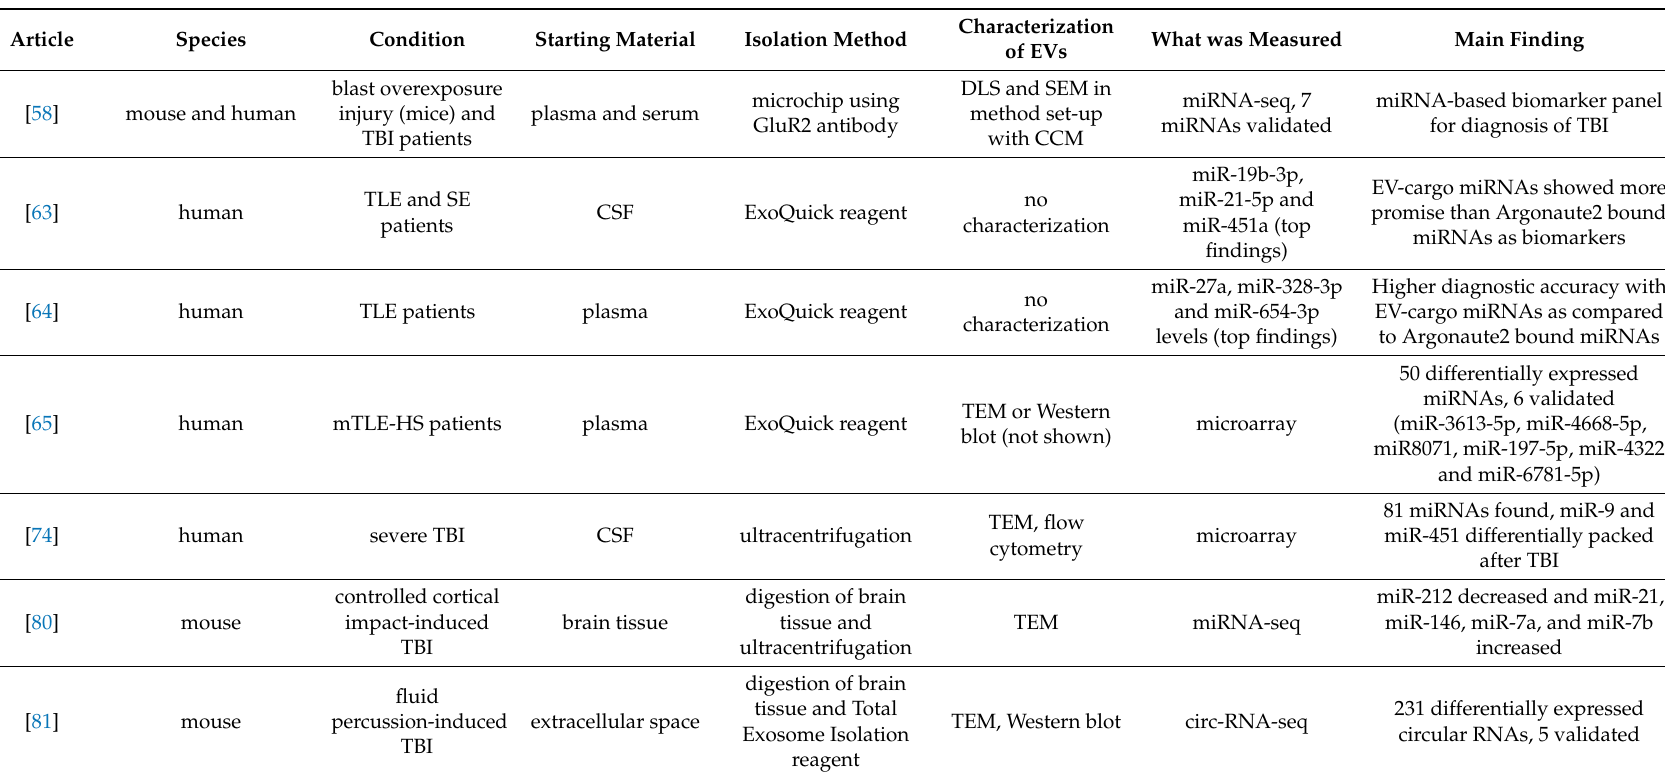
Table 3. Articles describing the changes in extracellular vesicle (EV) cargo RNA in status epilepticus (SE) and traumatic brain injury